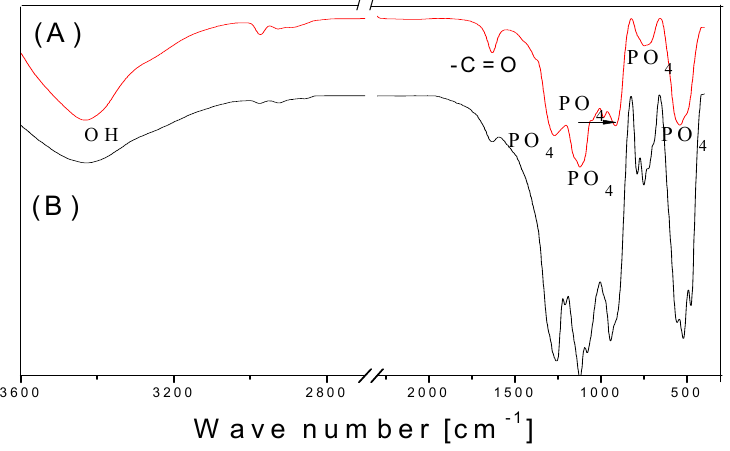
Figure 5. Fourier transform infrared spectroscopy (FTIR) spectra of the double layer coatings on Ti substrates after heat treatment at 550 °C for 30 min in air: (A) HA-CNT/TiO double layer coating; (B) HA/TiO double layer 2